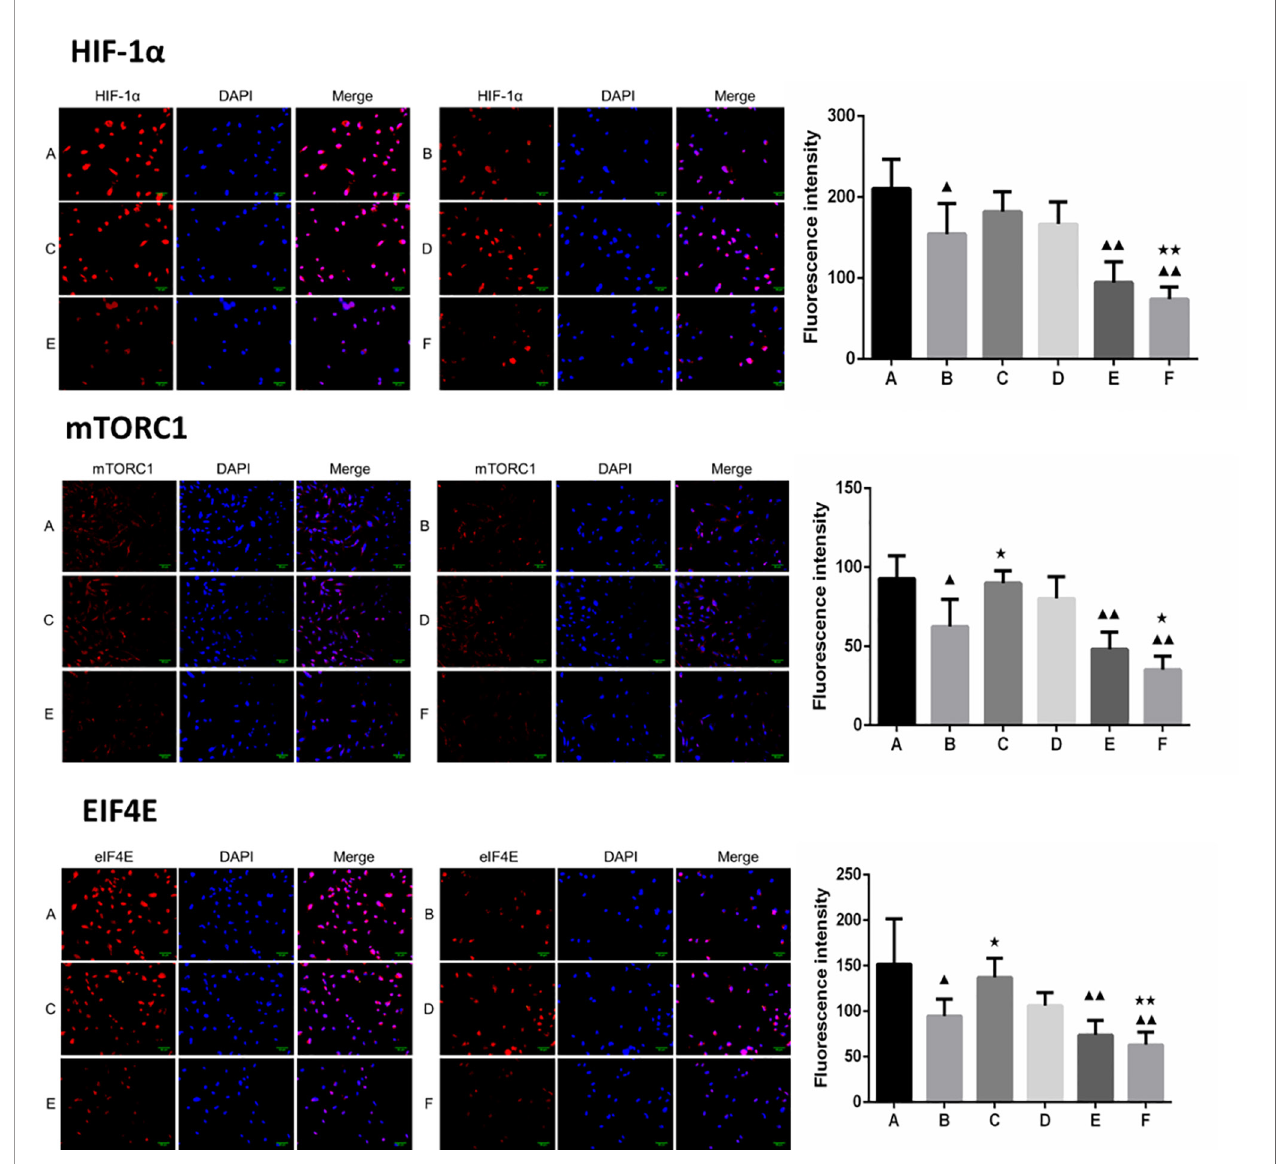
FIGURE 6 | Expression of HIF-1 a , mTORC1 and eIF4E in each group after borneol and radiotherapy treatment (200×) ( (cid:1) x ± S, n =5). (A) Control group (B) Radiotherapy 5Gy group (C) Borneol 20 m g/ml 24h group (D) Borneol 20 m g/ml 48h group (E) Borneol 20 m g/ml combined radiotherapy 5Gy group (F) Borneol 20 m g/ml 48h combined radiotherapy 5Gy group. Compared with the control group, ▲ P<0.05, ▲▲ P< 0.01; Compared with radiotherapy group, ★ P<0.05, ★★ P<